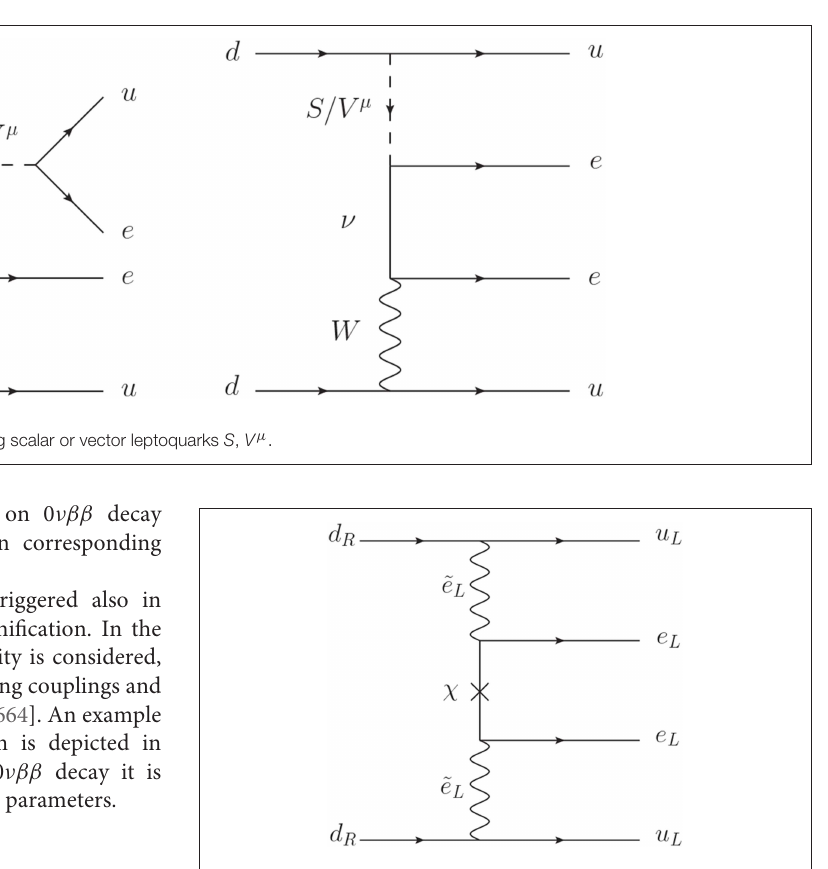
FIGURE 19 | An example of a 0 νββ decay mechanism that can be triggered in R-parity-violating